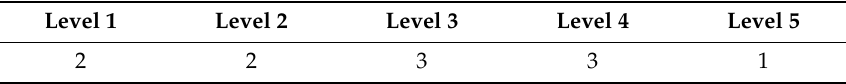
Table 1. Number of cold-rolled sheets per roping level.